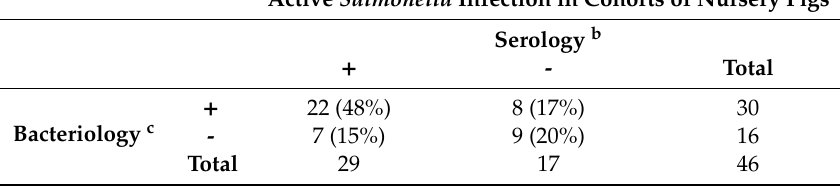
Table 5. Active Salmonella infection on 46 Ontario nursery cohorts a identified using bacteriological (at the end of nursery (V2)) and serological (based on pattern of antibody response from weaning (V1) to the end of the nursery) testing methods. Active Salmonella Infection in Cohorts of Nursery Pigs Serology b + - Total + 22 Bacteriology c